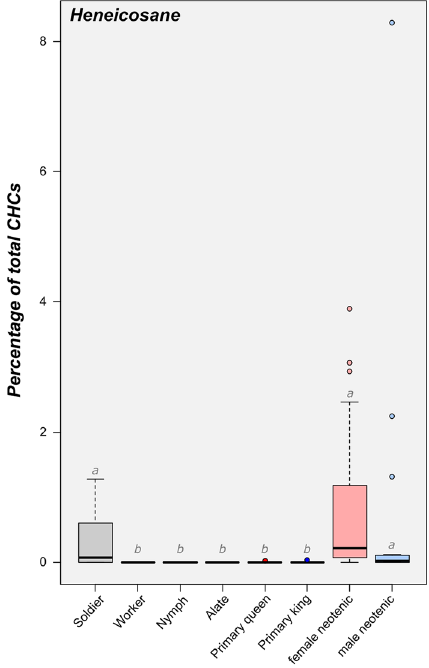
Figure 1. Representation of the relative proportion of heneicosane across castes and sexes of Reticulitermes flavipes . Box plots represent median and 1st and 3rd quartile; whiskers include 95% of all observations; individual dots show outlier values. Different lower case letters indicate significant differences between groups. Dark red markers represent primary queens, dark blue represent primary kings, light red markers represent female neotenics and light blue represent male neotenics. Non-reproducing castes (soldier, worker, nymph and alate) are depicted in